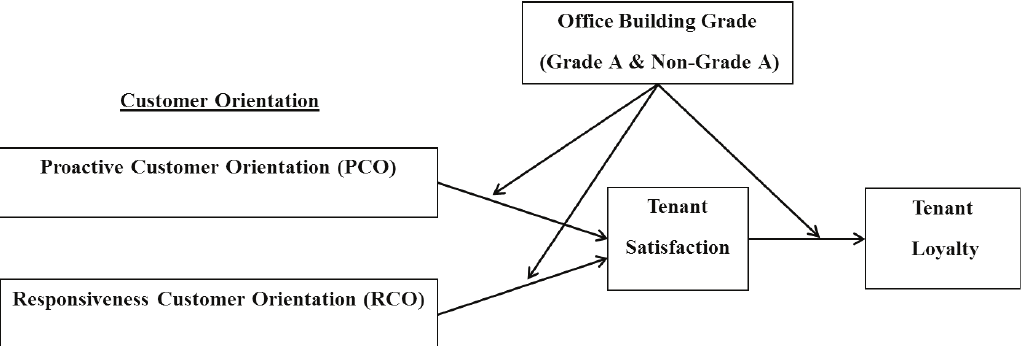
Figure 1. Research